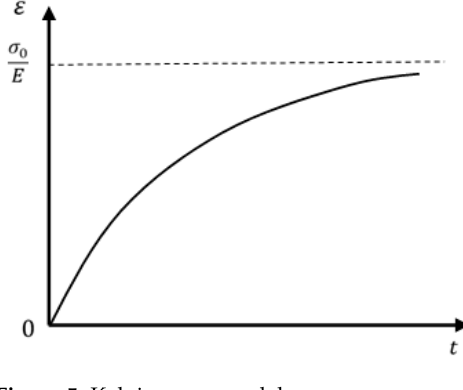
Figure 5. Kelvin creep model.